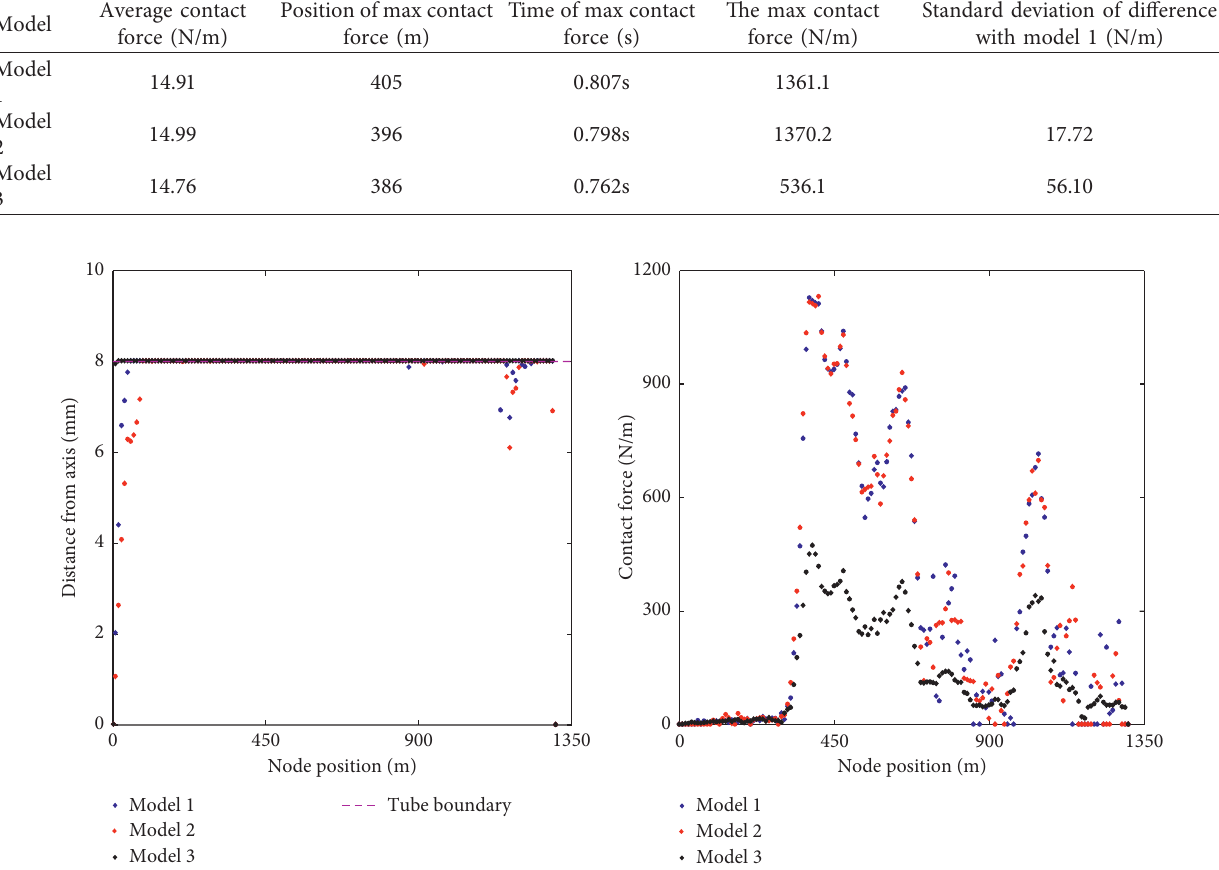
Figure 5: Simulation results of model 1. (a) Distance between the node position and the borehole axis. (b) Contact force between rod and tube. Table 1: Statistical table of rod-tube contact force characteristic values in one cycle.